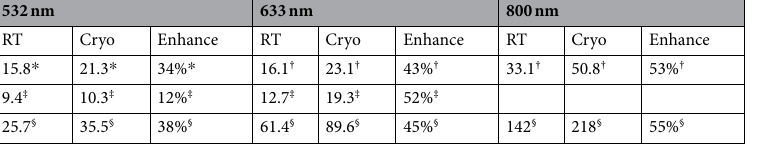
Table 1. Summary of the L SP (unit in µ m) and the enhancement at low temperature. * Chemical Expt. † MBE Expt ‡ Sputtering Expt § Sputtering